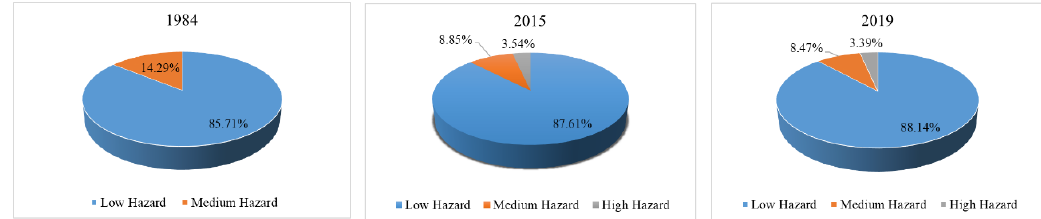
Figure 14. The exposed percentage areas for the flood hazard levels over time from 1984 to 2019 in Salloum.